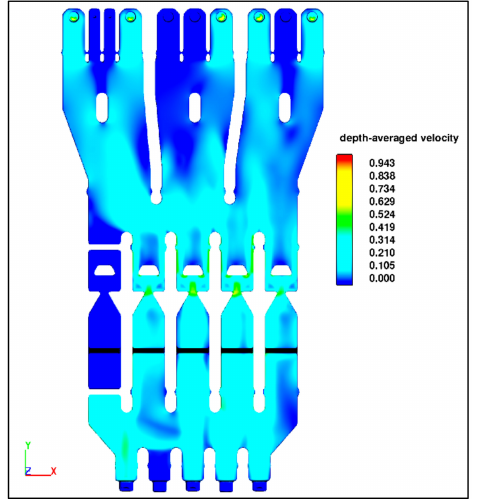
Figure 13. Velocity contours at the basin for scenario V—3D